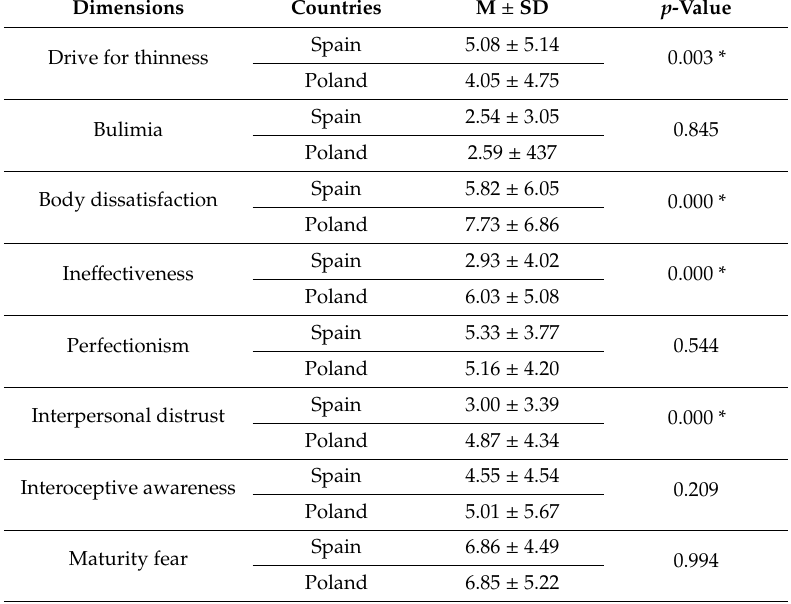
Table 4. Cognitive and behavioural features of eating disorder (ED) among students from Spain and Poland.